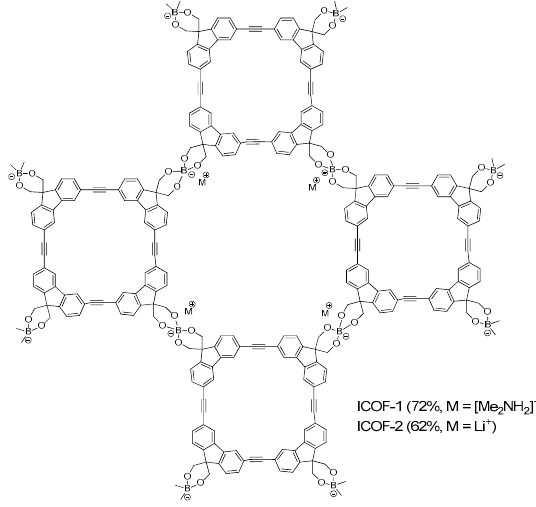
Figure 9. Construction of spiroborate-linked COFs featuring anionic skeletons with various counter ions for high ionic conductivity.